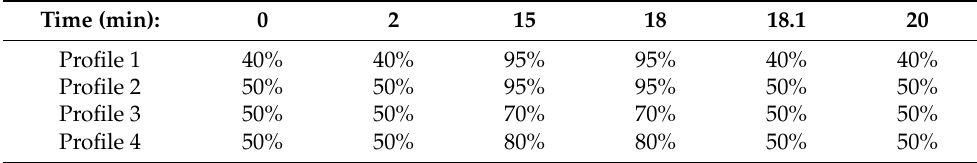
Table 2. Gradient profiles of mobile phase B.